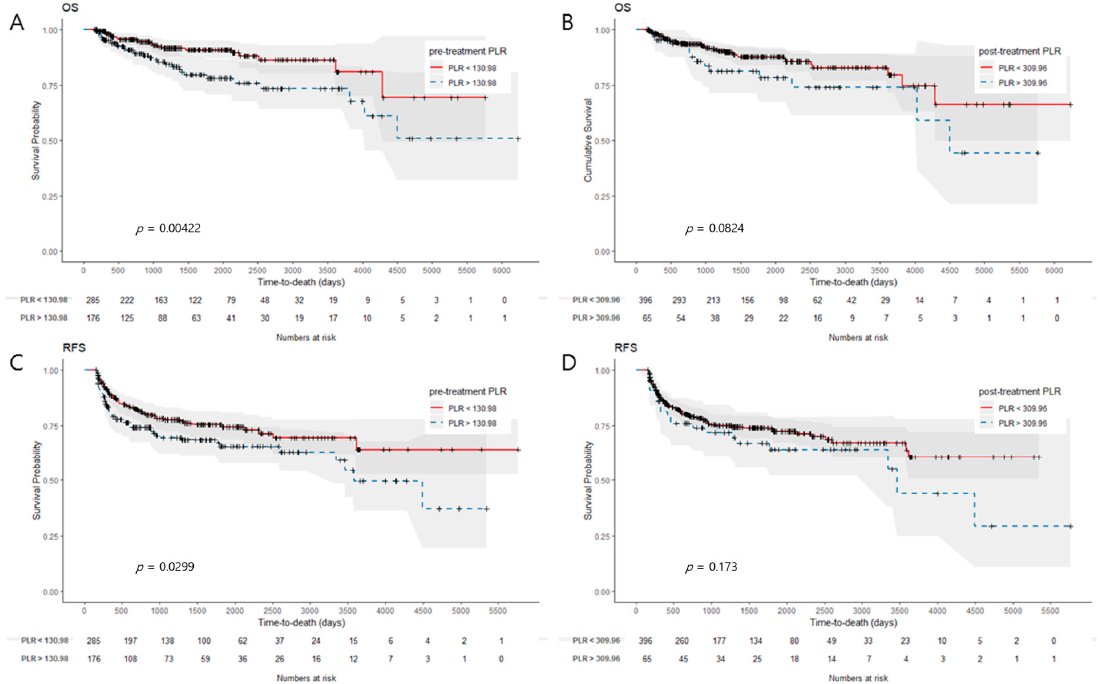
Figure 4. Kaplan–Meier survival curves for OS and RFS according to different levels of PLR. ( A , B ) High pre-treatment PLR and high post-treatment PLR was related to significantly worse OS ( p = 0.004 and p = 0.082, respectively); ( C , D ) High pre-treatment PLR was related to significantly worse RFS ( p = 0.030). No significant difference in RFS was observed between high and low post-treatment PLR groups ( p = 0.173).